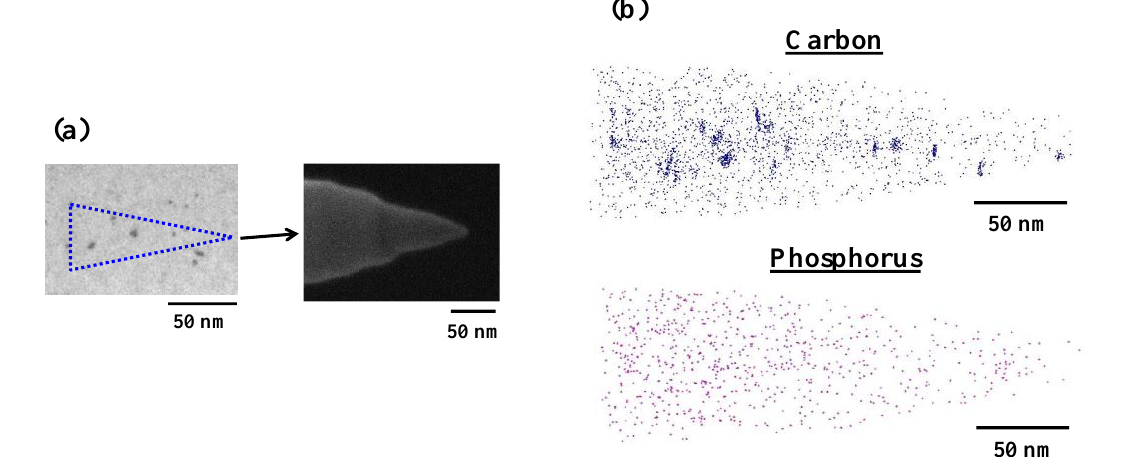
Figure 11. ( a ) TEM (left) and SEM (right) images of acicular sample for L-ATP. ( b ) 3D-APT map of carbon and phosphorus in CH 2 P-molecular-ion-implanted region after epitaxial growth.